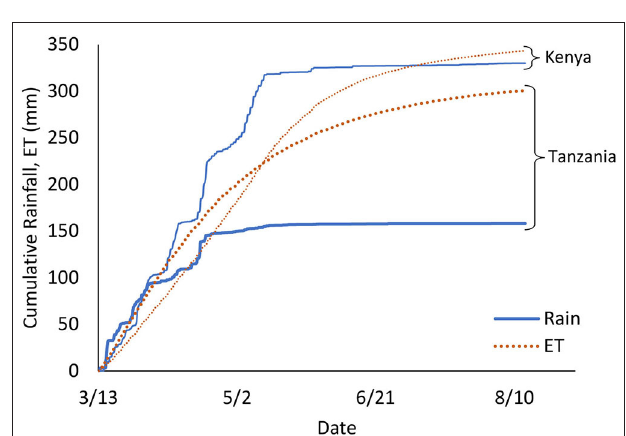
FIGURE 4 | Kenya receives more rainfall in two rainy seasons each year and experiences less ET throughout the year than Dodoma. For the study duration, Kenya receives an additional 172 mm of rainfall and experiences 43 mm more ET. Also, note that Kenya’s rainy seasons ends about 3 weeks after the end of Tanzania’s rainy season. Kenya’s intraseasonal rainfall variability involves high-volume rain events spaced out, whereas Dodoma is likely to have more frequent, smaller volume rain